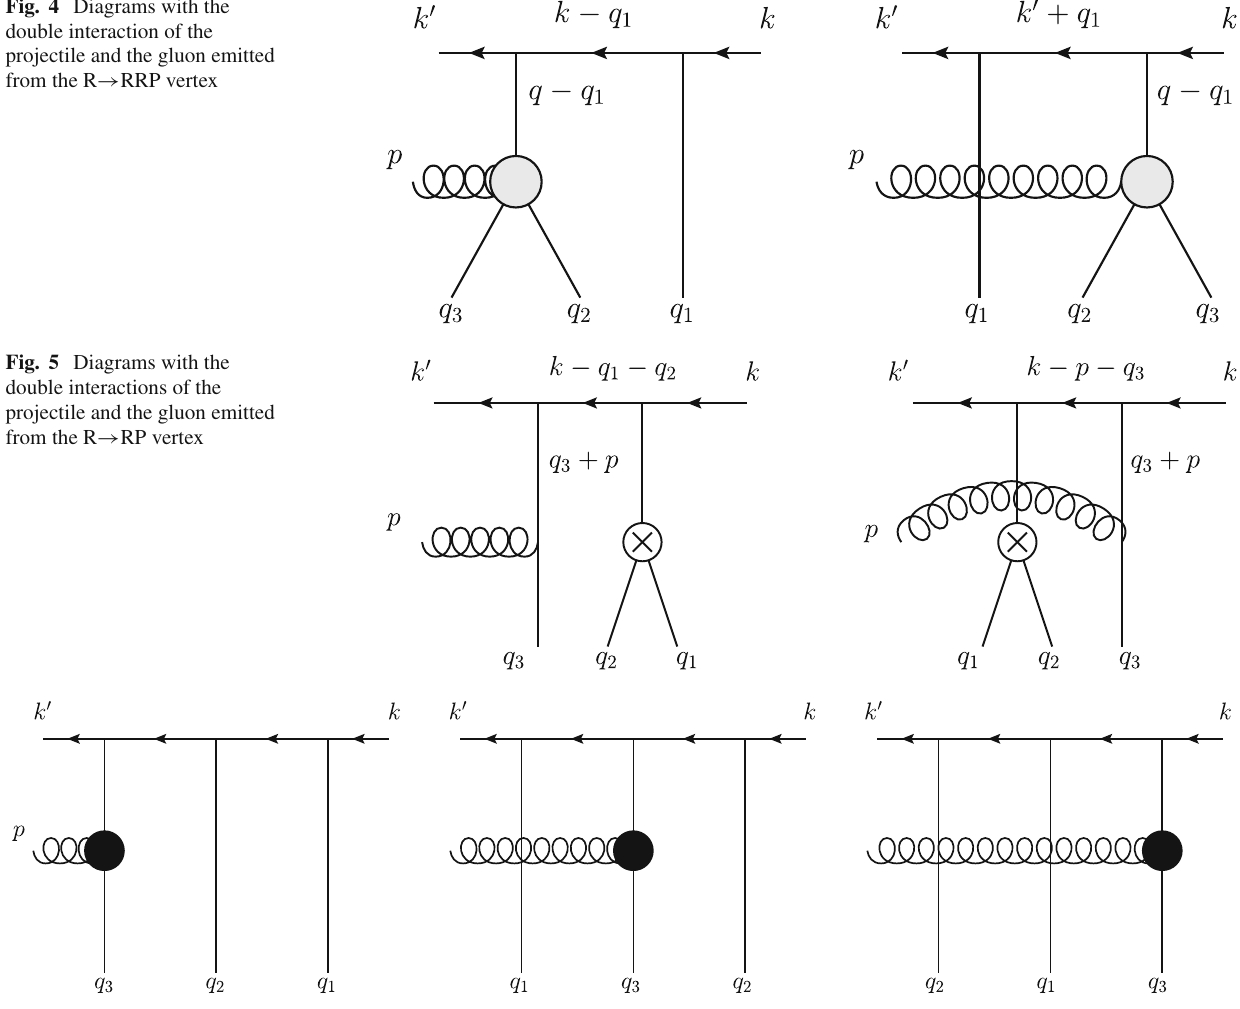
Fig. 4 Diagrams with the double interaction of the projectile and the gluon emitted from the R → RRP vertex